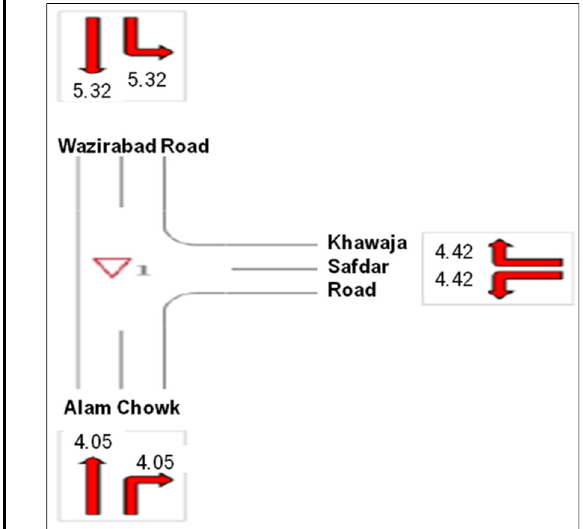
Fig. 8: Degree of Saturation in Existing Condition at Model Town